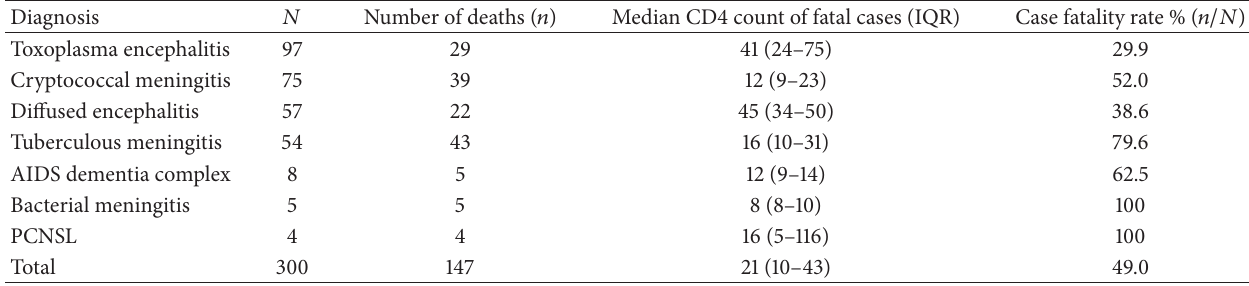
Table 4: In hospital mortality by aetiology in our study population of 300 HIV positive patients.